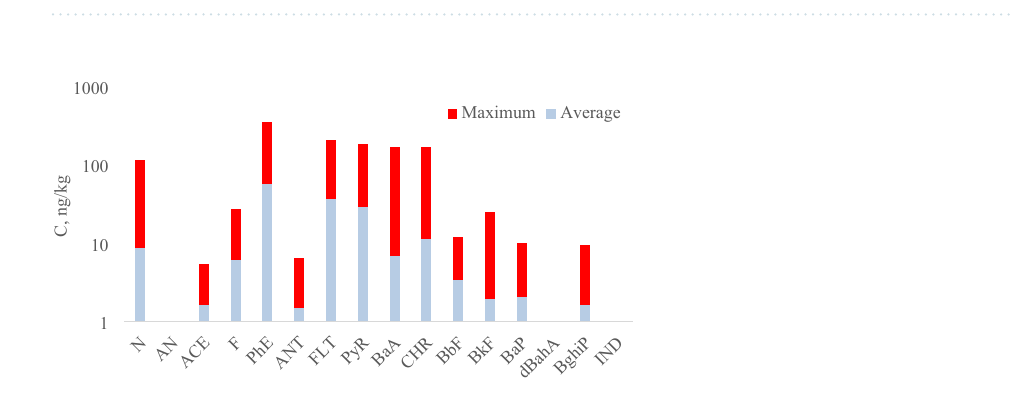
Figure 2. Snow sampling points and the toxic equivalency value. The map was created using the ArcGIS ver. 10.4.1 for desktop (https:// deskt op. arcgis. com/ en/).